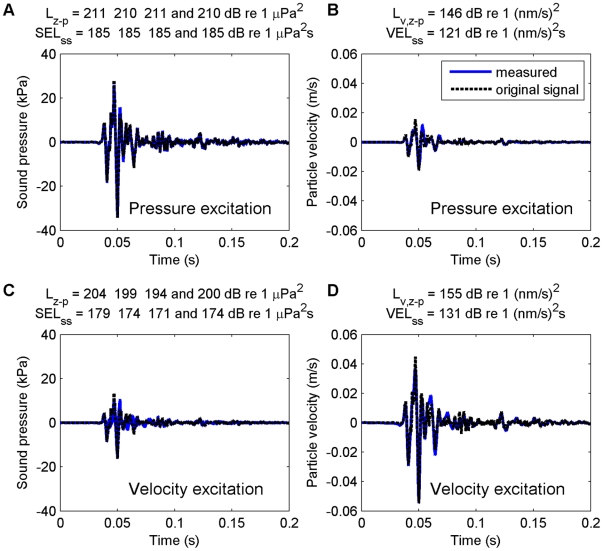
Comparison of the original and measured signal shape.Comparison of the original signal shape (recorded in the field) and the observed signal shape (measured in the larvaebrator) for a pressure excitation (A, B) and a velocity excitation (C, D), in terms of sound pressure (A, C) and sound particle velocity (B, D). The original signal is scaled to match the peak of the measured signal. The sound levels are given in the header of each panel.